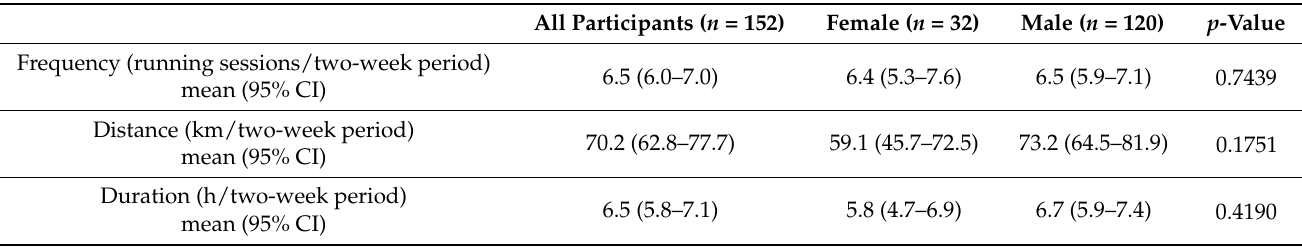
Table 2. The participants’ ( n = 152) mean (95% CI) running exposure (frequency, distance, and duration of running) over 15 two-week periods.